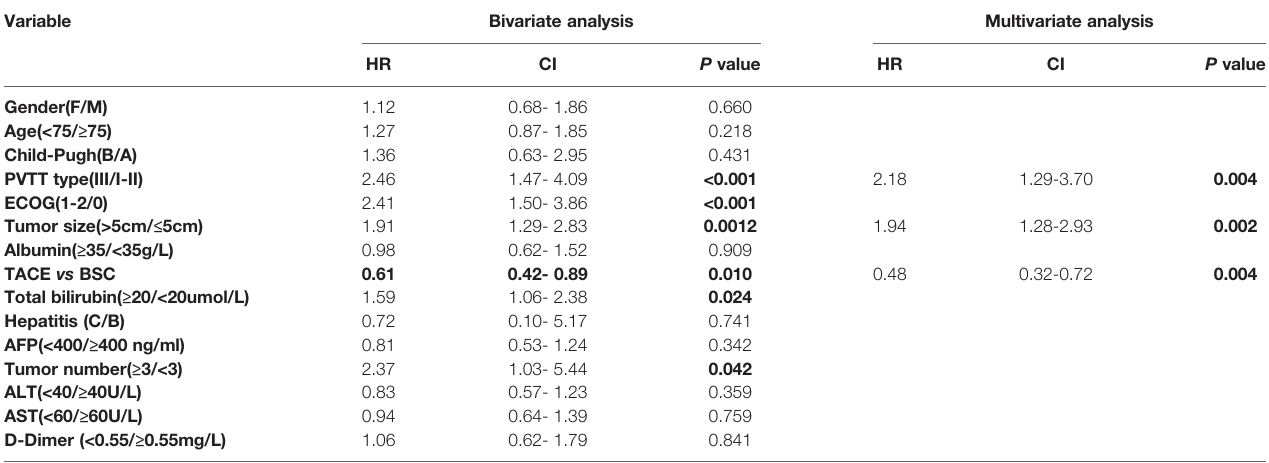
ElderlyHCCpatientsreceivedtheTACEtreatmenthad52%lowerhazardsofmortalitycomparedwiththeBSCgrouppatients(p<0.001).MultivariableCoxproportionalhazardsregression analysis revealed that PVTT types (type III vs type I-II) and tumor diameter (>5cm vs ≤ 5cm) (p<0.005) were independent indicators of overall survival. ECOG, Eastern Cooperative Oncology Group; AFP, Alpha – fetoprotein;ALT, Alanine aminotransferase; AST, Aspartate aminotransferase; TACE, Transarterial Chemoembolization. Bold values marked the signi fi cant P values (P <